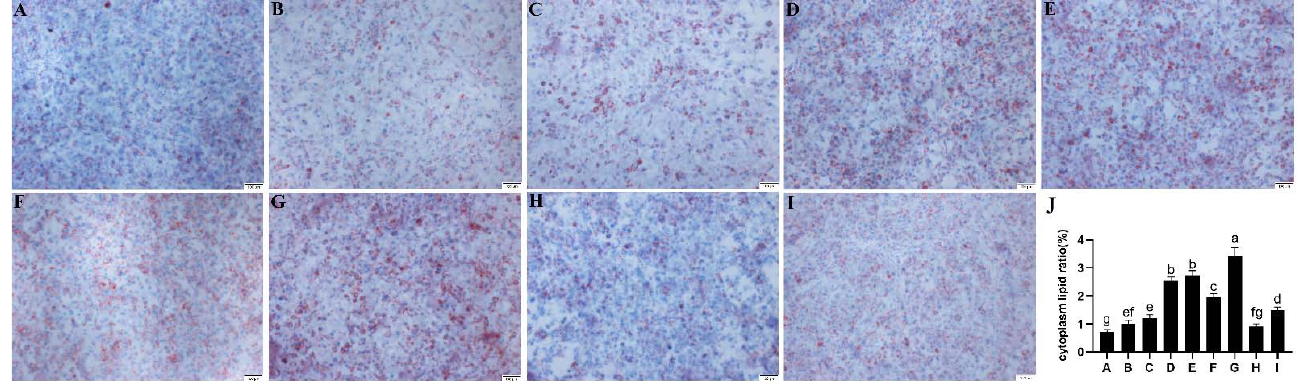
Figure 6. Effect of C/EBP α , MF3 and OVR overexpressed vectors on the transportation of serum lipid. ( A ) DF ‐ 1 cells without any performance. ( B ) DF ‐ 1 cells transfected with pEGFP ‐ N1 vector without insertion of cDNA. ( C ) DF ‐ 1 cells transfected with OE ‐ MF3 vector. ( D ) DF ‐ 1 cells transfected with OE ‐ C/EBP α vector. ( E ) DF ‐ 1 cells transfected with OE ‐ OVR vector. ( F ) DF ‐ 1 cells transfected together with OE ‐ MF3 and OE ‐ OVR vectors. ( G ) DF ‐ 1 cells transfected together with OE ‐ C/EBP α and OE ‐ OVR vectors. ( H ) DF ‐ 1 cells transfected together with OE ‐ MF3 and sh ‐ 3 vectors. ( I ) DF ‐ 1 cells transfected together with OE ‐ C/EBP α and sh ‐ 3 vectors. ( J ). Cytoplasm lipid ratio (%), a–g: different letter means significant difference ( p < 0.05).